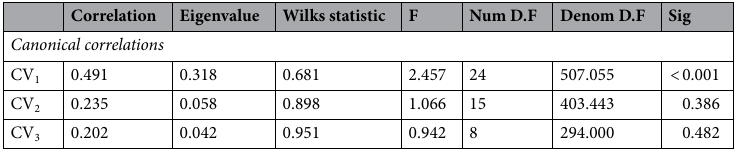
Table 1. Canonical correlations between the two sets of variables in Spring. The first canonical variable (CV 1 ) shows a significant correlation ( p = 0.001), while the other canonical variables showed non-significant effects. H 0 for Wilks test is that the correlations in the current and following rows are zero.